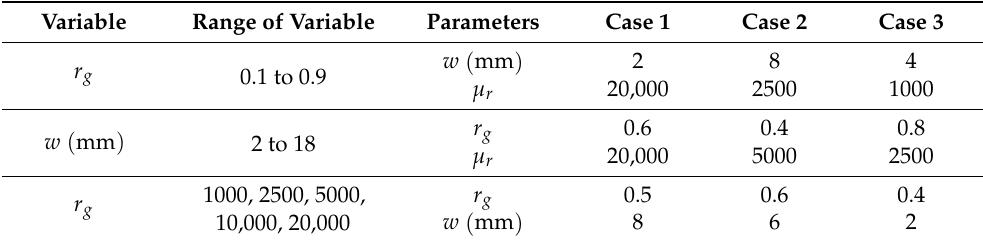
Table 1. Range of variables and corresponding studied